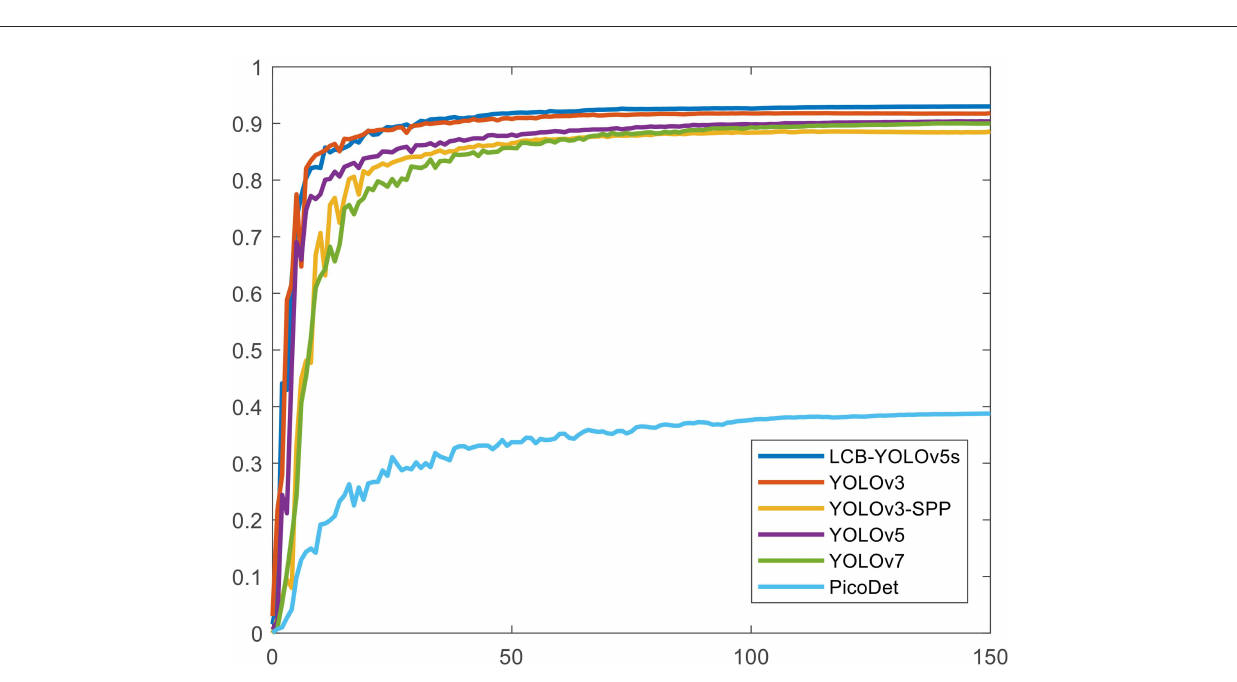
FIGURE15 The mAP (the threshold is 0.5) of the proposed method in comparison with the other five detection algorithms on the DIOR-VAS